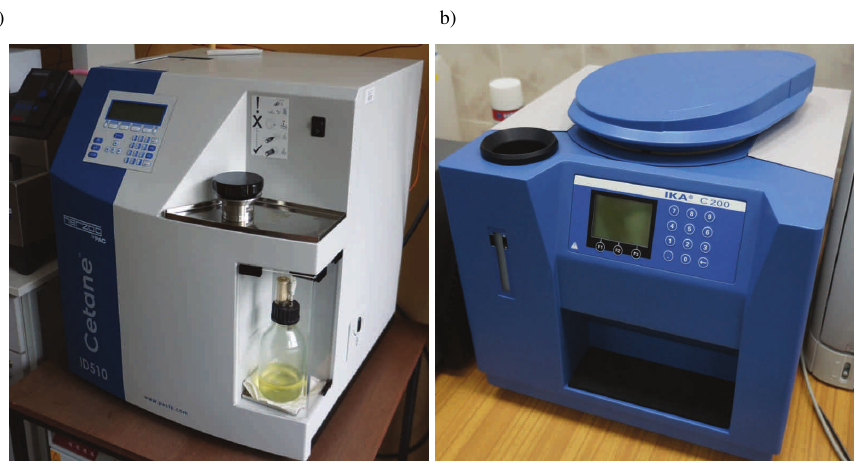
Fig. 2. Research devices: (a) Cetane ID 510 Cetane Analyzer; (b) IKA C200 Automated Bomb Calorimeter